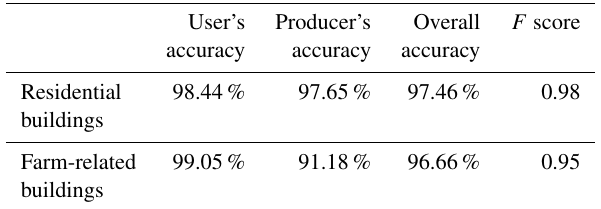
Table 2. Accuracy assessment